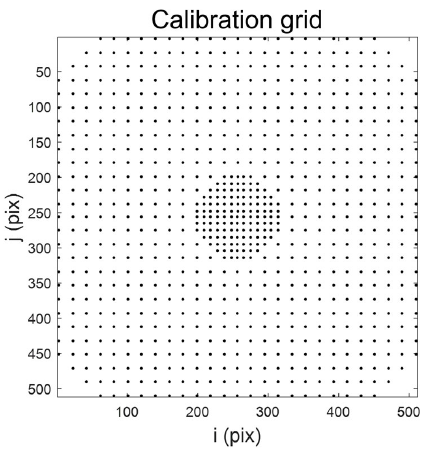
Figure 10. Calibration grid for the scaling interpolation method. The grid is regularly spaced everywhere but at the center where the density is doubled.